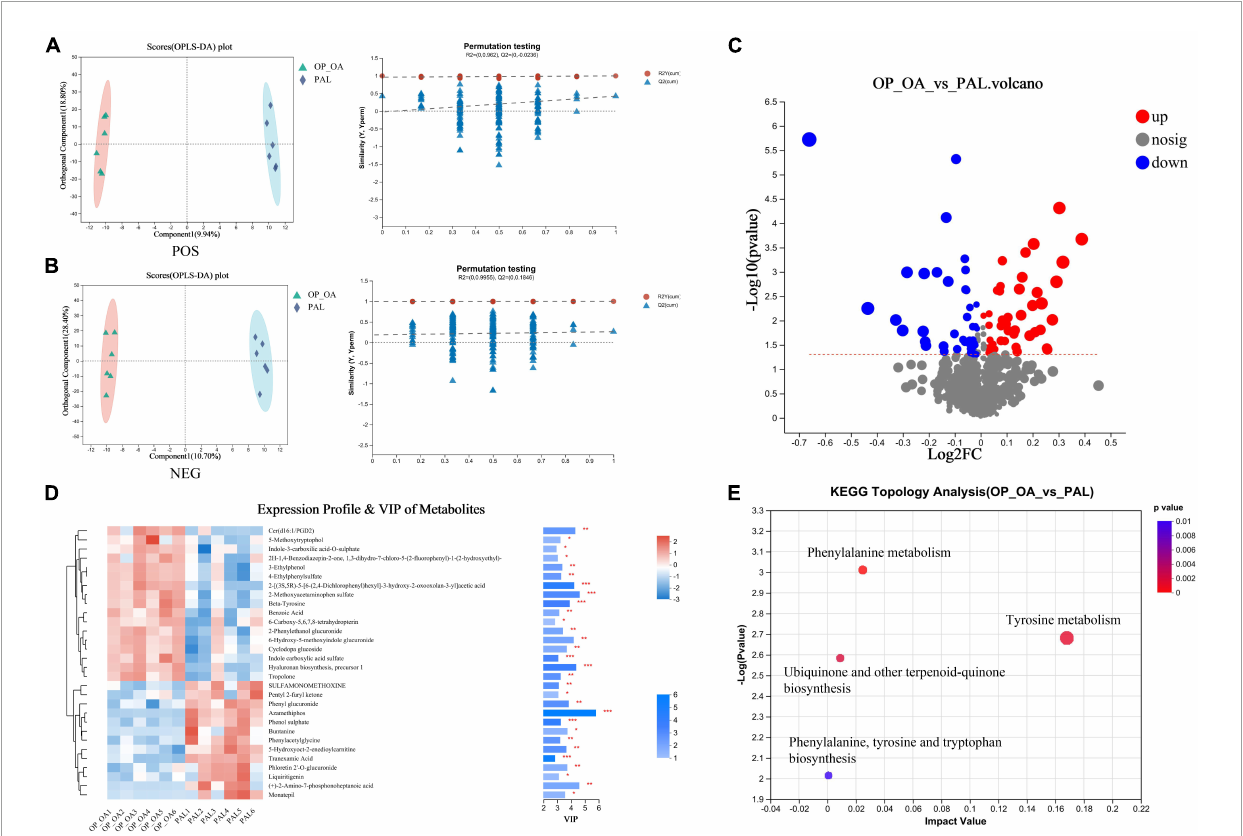
FIGURE6 Metabonomic analysis. (A) OPLS-DA score plot and OPLS-DA permutation test chart (POS); (B) OPLS-DA score plot and OPLS-DA permutation test chart (NEG); (C) comparison between OA-OP and PAL single-dimensional metabolite volcano map. Threshold setting p < 0.05 and | log2fc | ≥ 1 (FC, fold change); (D) VIP analysis chart. The left side is the metabolite cluster tree, and the color represents the relative expression amount of this metabolite in this group of samples. The right side is a VIP bar graph of metabolites. The bar length indicates the contribution value of the metabolite to the difference between the two groups. The larger the value, the greater the difference between the two groups. The bar color indicates the significant difference in metabolites between the two groups of samples. (E) Metabolic pathway analysis of plasma differential